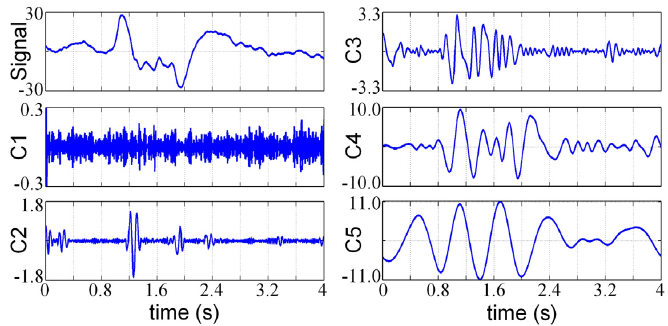
Figure 5. IMF components of an adult's PIR signal, where C i is the i th IMF component.